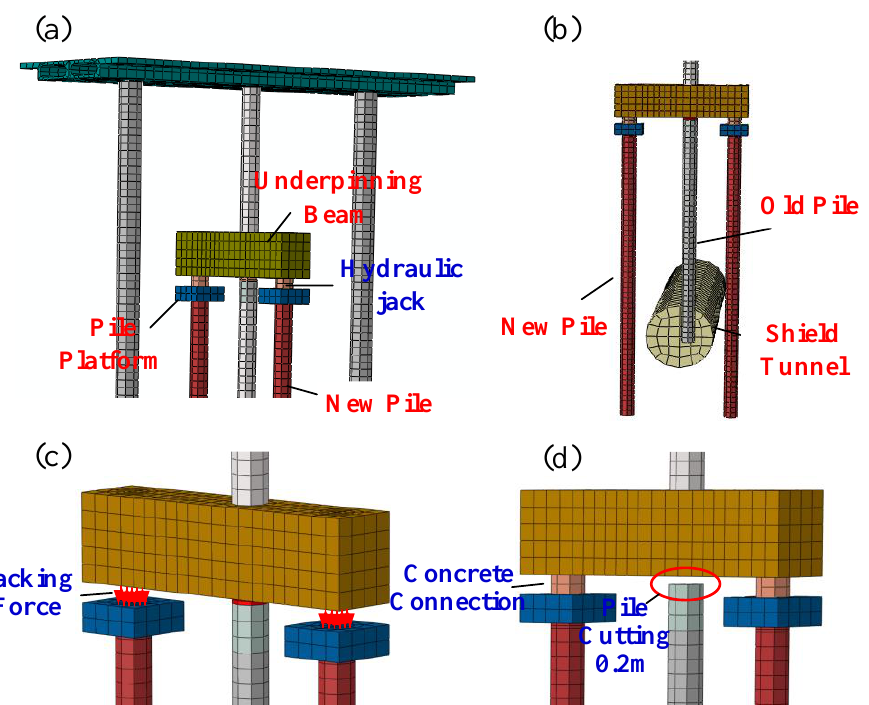
Figure 5. Details of the 3D-FEM modelling: ( a ) underpinning diagram; ( b ) location of the underpin- ning pile and shield tunnel; ( c ) application of jacking force; and ( d ) old pile cutting and new pile sealing.